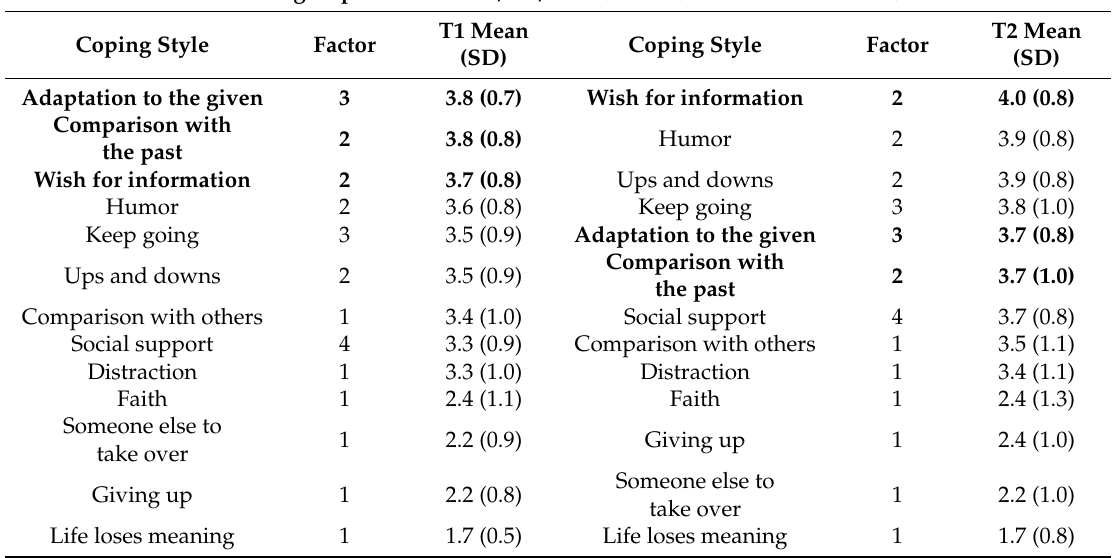
Table 5. Rating of coping styles over time, by Hoehn and Yahr (HY) subgroup; Factor solution revealed at baseline, in short: 1 = pessimistic, 2 = optimistic, 3 = persistent, 4 =